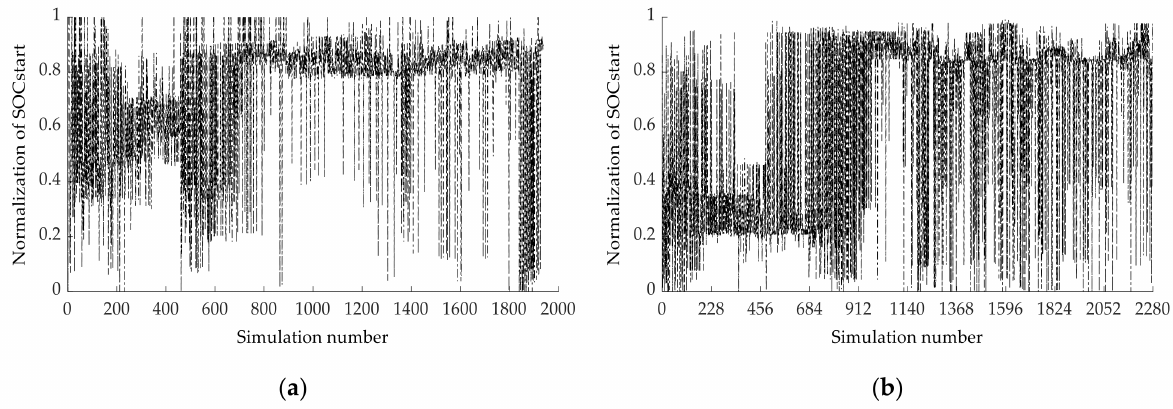
Figure 17. Variation of control variable SOC start . ( a ) VDPM displacement is 180 mL/r; ( b ) VDPM displacement is 125